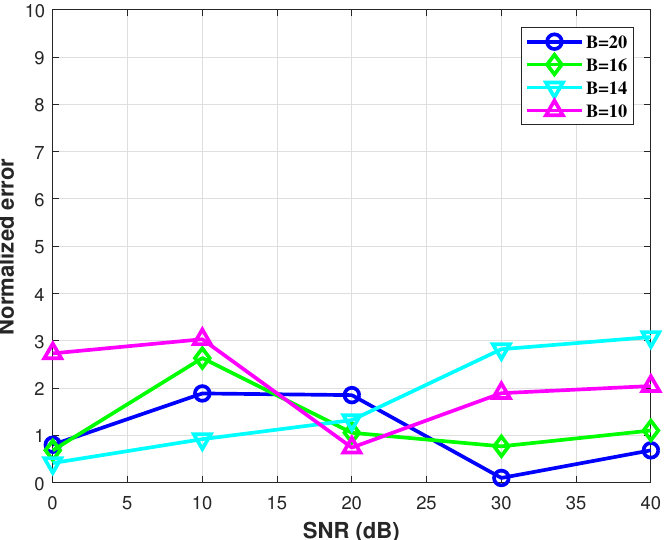
Figure 5. Normalized error of the theoretical IA sum-rate with RVQ-based CSI feedback in ( 2 × 2,1 )